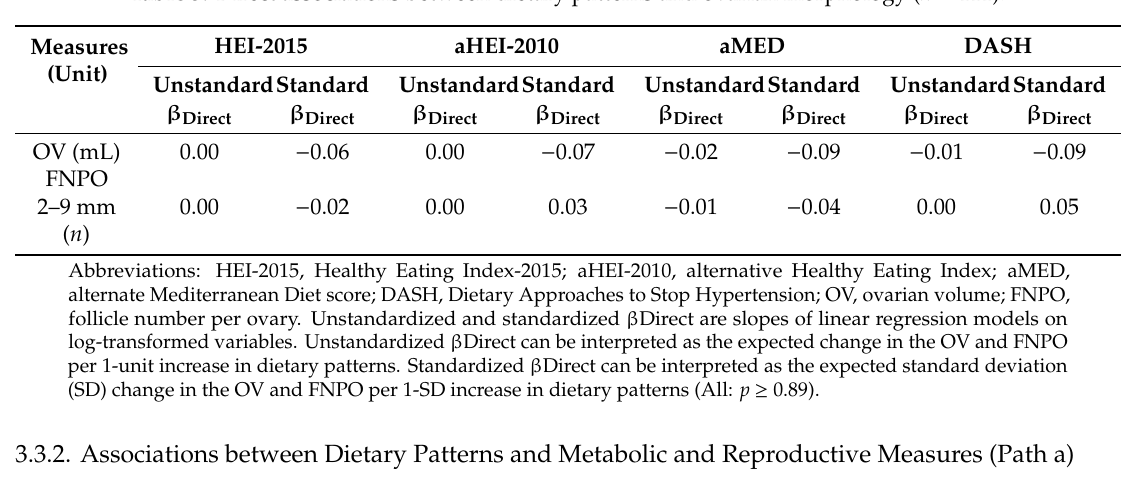
Table 3. Direct associations between dietary patterns and ovarian morphology ( n =